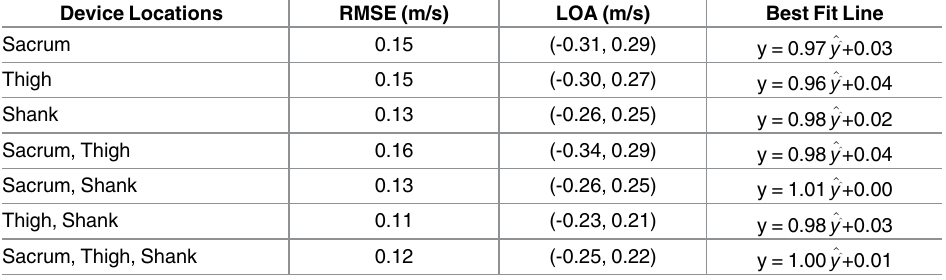
Table 1. Error metrics for treadmill walking data from healthy subjects for 7 device location combinations.